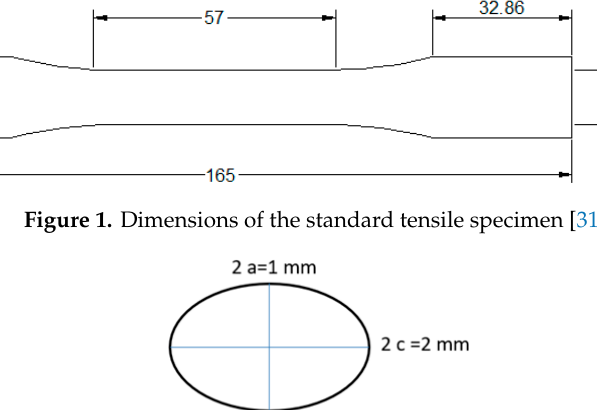
Table 2. Process parameters for FDM [31].